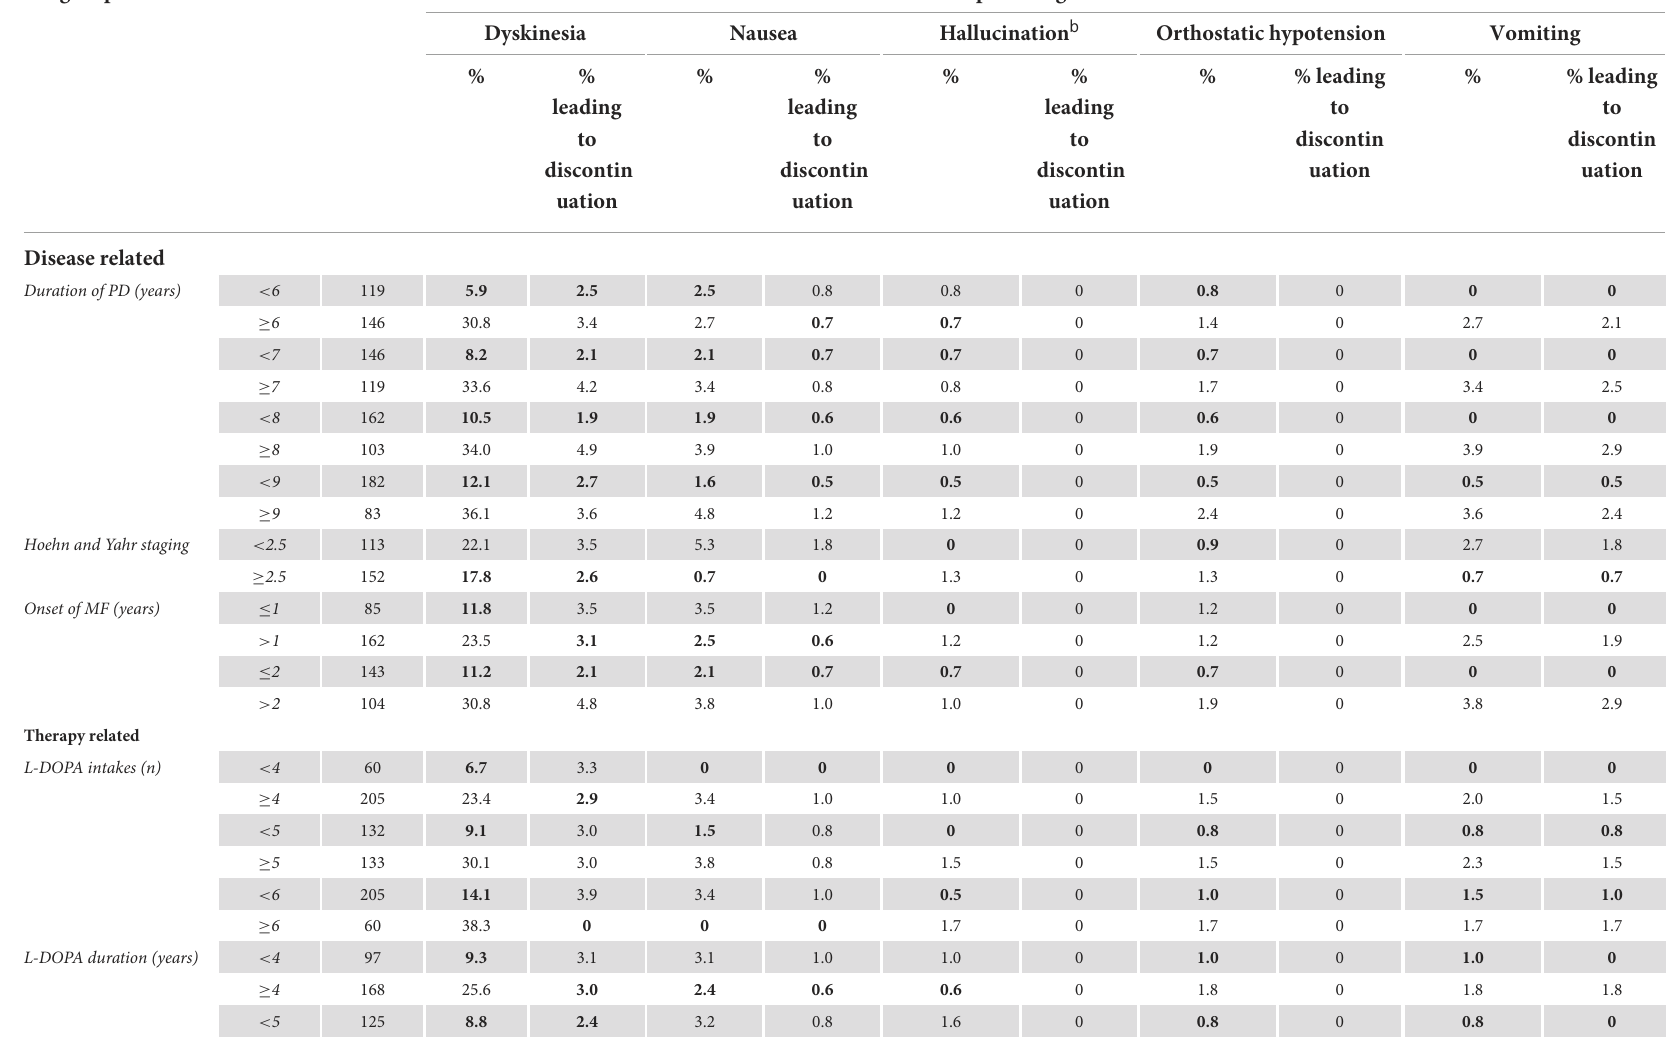
TABLE 2 Summary of related a dopaminergic-related TEAEs and related a dopaminergic-related TEAEs leading to discontinuation in specific OPC 50mg subgroups (Safety